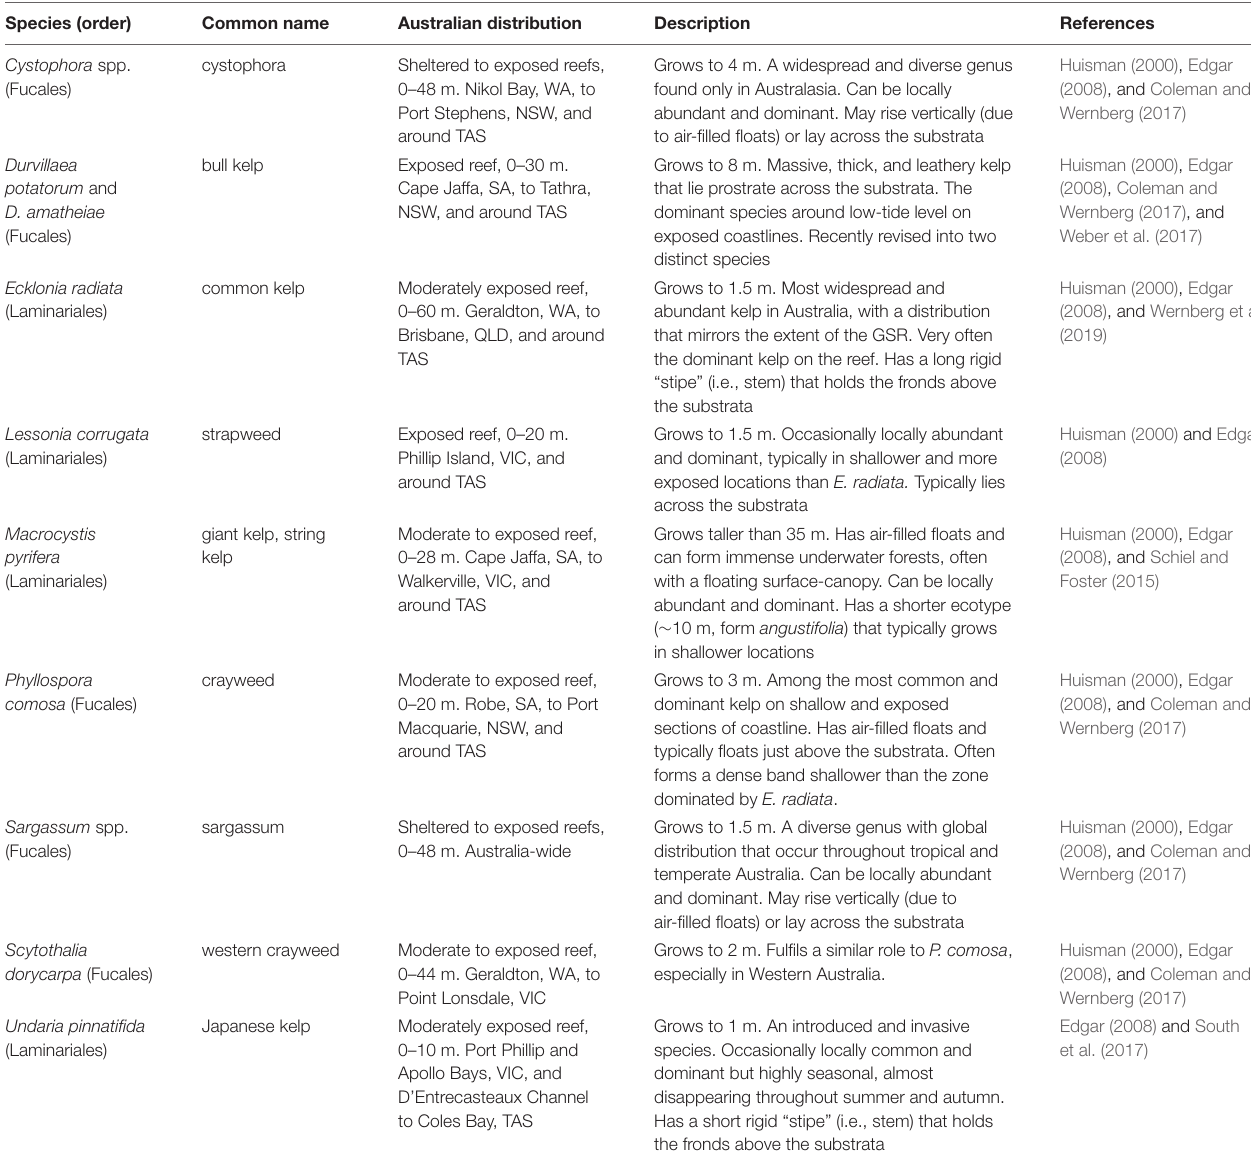
TABLE 1 | The primary genera/species of habitat-forming kelp in Australia. Unlike the northern hemisphere where kelp canopies primarily consist of “true” laminarian kelps, canopy-forming species in Australia constitute both laminarian and fucalean algae, with a larger diversity of fucoids than